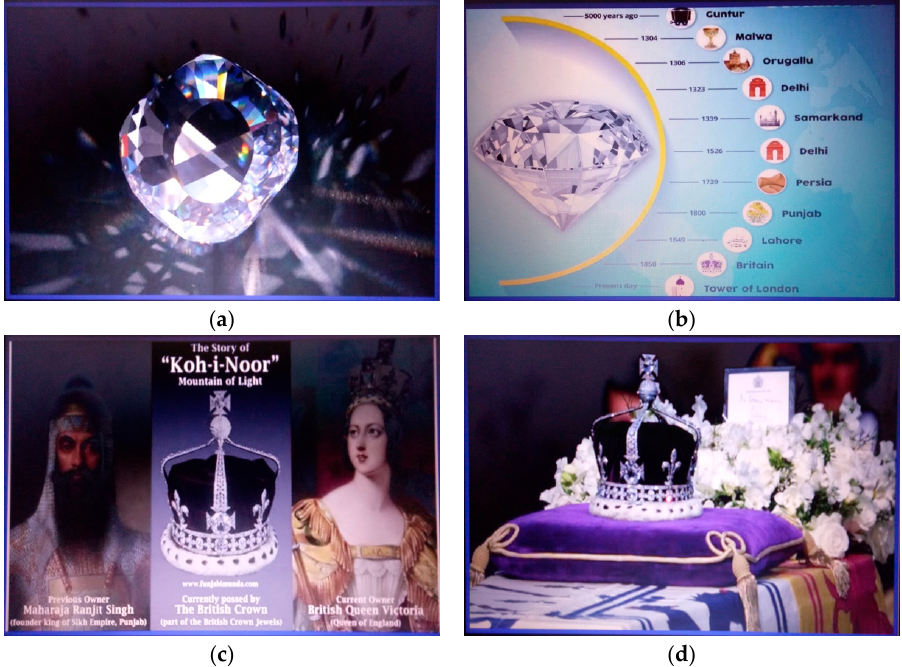
Figure 15. Received Stego Image( a ) Image 1, ( b ) Image 2, ( c ) Image 3, ( d ) Image 4.